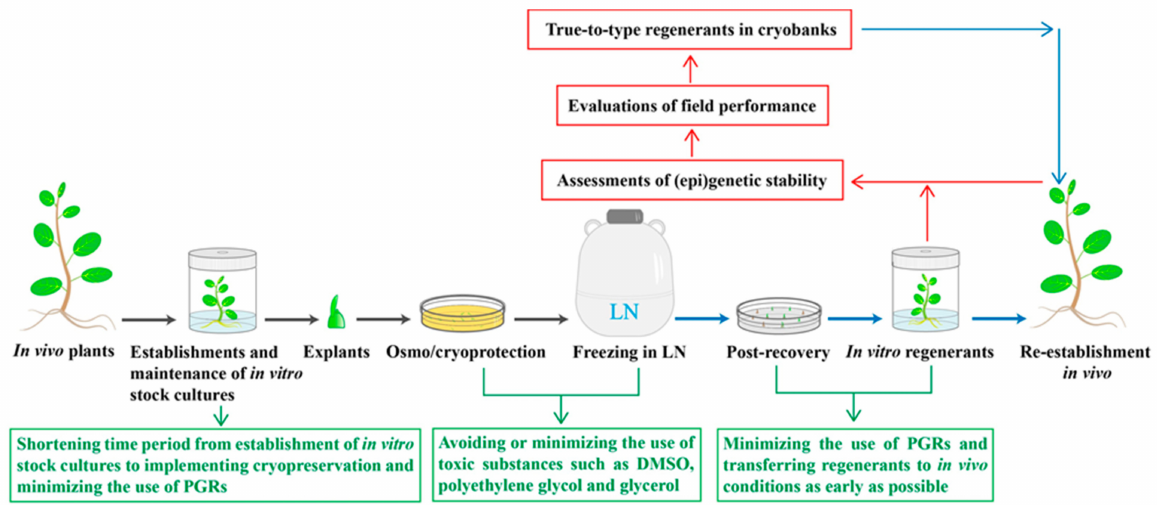
Figure 1. General cryopreservation procedures (black arrows), post-culture for recovery and re-establishment of plants in vivo (blue arrows), assessments of (epi)genetic stability and evaluations of field performance in cryo-derived regener- ants/plants (red arrows), and measures taken to ensure (epi)genetic stability and true-to-type regenerants/plants recovered after cryopreservation (green arrows). DMSO, dimethyl sulfoxide; LN, liquid nitrogen; PGRs, plant growth